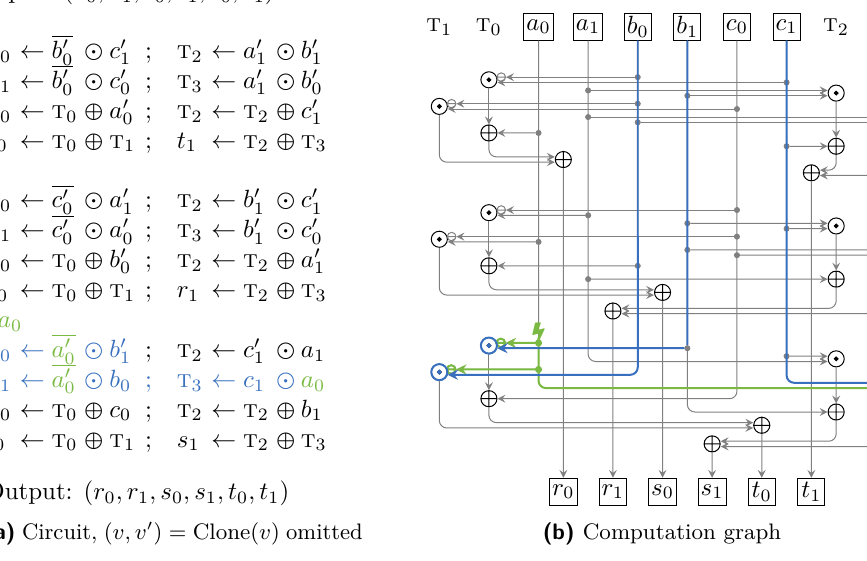
Figure 3: Bitflip in masked χ 3 using 2 shares (resharing at the output